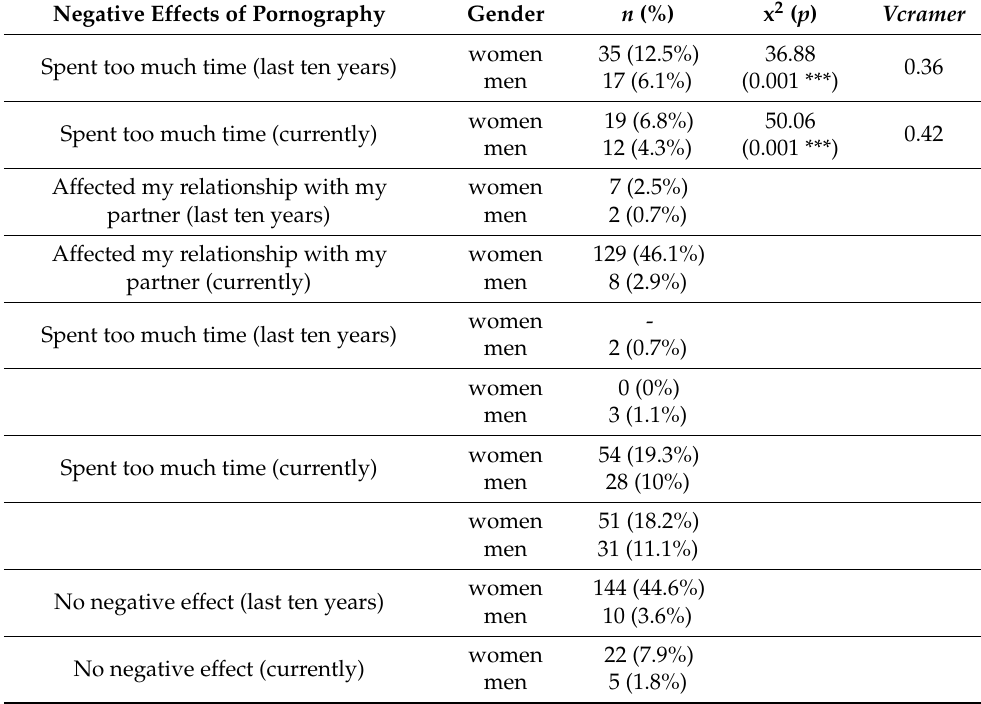
Table 5. Current Negative Effects according to